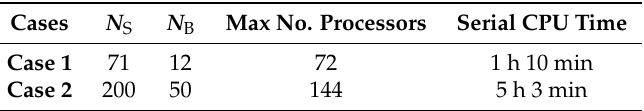
Table 1. Test case characteristics.